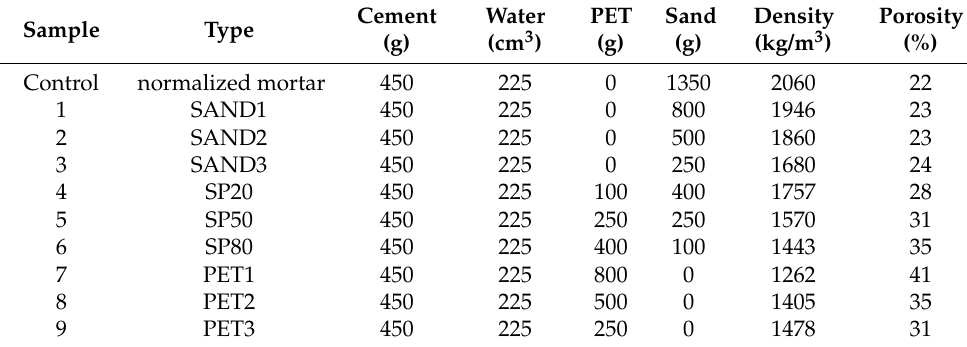
Table 1. Composition, density ρ and porosity of the cement mortars.